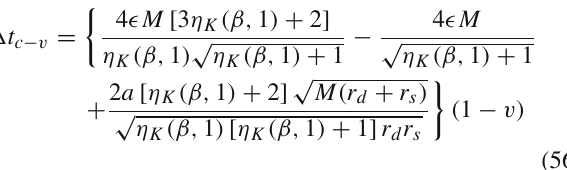
In Fig. 4, we plot (cid:2) t c − v between time delays of light sig- nal and a timelike signal with velocity v = ( 1 − 3 × 10 − 15 ) c as a function β and r s = r d = D . The 3 × 10 − 15 c is the maximal deviation that GW speed can get from the speed of light [27,28]. The above three cases of dominance are then separated by the red and blue curves, which are plotted using = a / r β 2 r = M respectively. As discussed β 2 r s , d s , d and s , d above, in the regions below the red curve (or above the blue curve), the third term (or first term) dominates the time